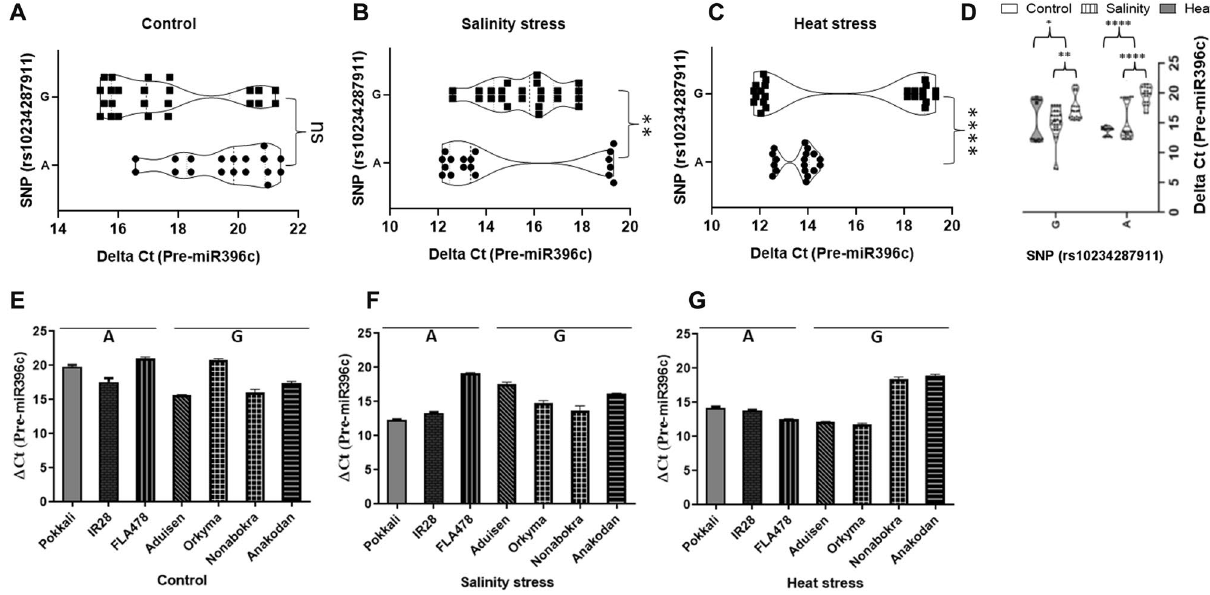
Figure 6. qRT-PCR analysis of pre- miR396c expression under control (untreated), salinity and heat treatments in rice landraces/varieties grouped either ‘A’ or ‘G’. Violin plots representing ΔC T values for pre- miR396c expression under control conditions in ( A ), salinity in ( B ) or heat stress in ( C ) for landraces/varieties grouped either as ‘A’ or ‘G. In E–G, ΔC T values for pre- miR396c expression for individual landraces under the same conditions is shown. Pairwise statistical analysis of pre- miR396c expression in landraces/varieties grouped either ‘A’ or ‘G’ ( A – C ) or within landraces/varieties grouped ‘A’ or ‘G’ (control vs salinity or heat) using pairwise Student’s t-test (GraphPad V 6.0). Data is for three biological replicates per landrace/varieties per treatment (n = 3) with two/three technical